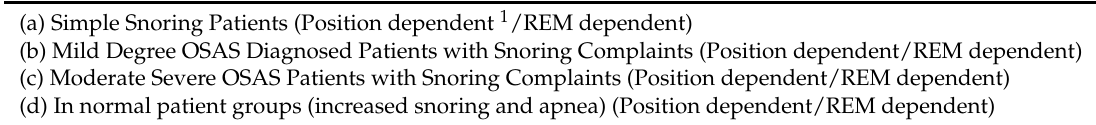
Table 2. Patient groups that cannot be proposed CPAP and not fully